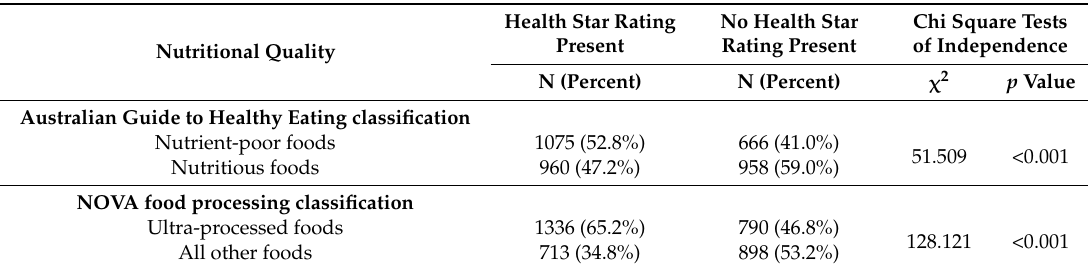
Table 4. Chi-square test of independence between presence of HSR on the front-of-pack of supermarket own brand foods and their nutritional quality.